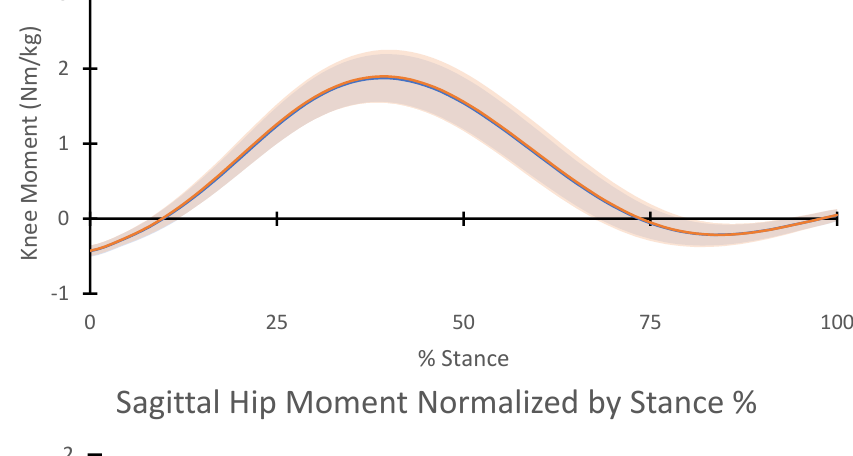
The shaded areas represent standard deviations for each part of the stance phase. The female shoe (C1) is represented in blue, and the male shoe (C2) is represented in